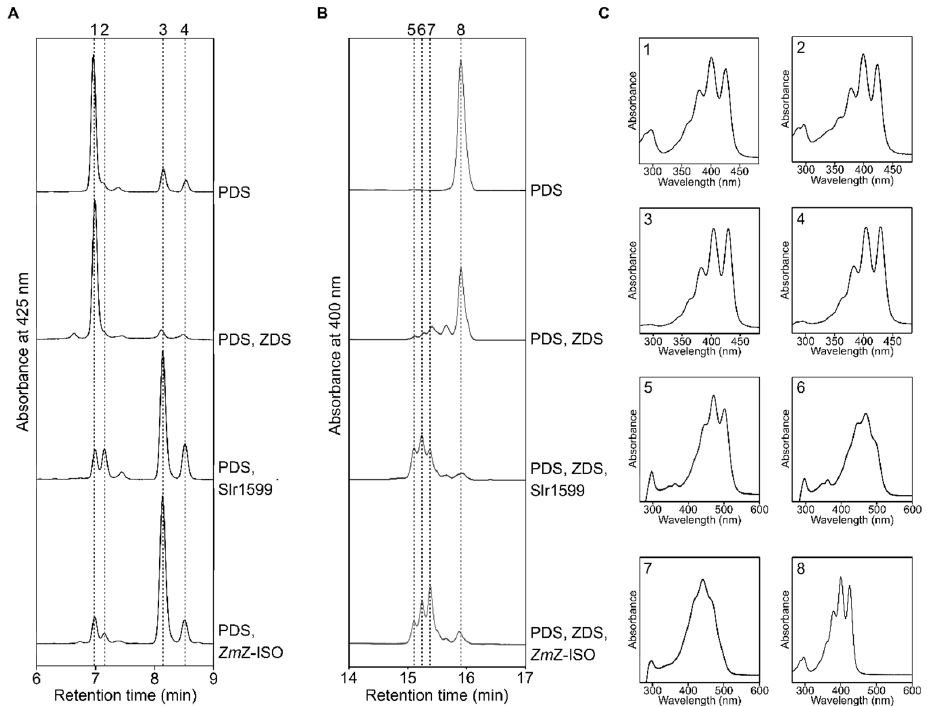
Figure 3. Slr1599 isomerizes 9,15,9 (cid:48) -tri- cis - ζ -carotene when produced in E. coli . ( A ) RP-HPLC anal- ysis of carotenoids extracted from dark-grown E. coli cells containing pAC-ZETAipi and either empty pCDFDuet Tm -1 (labeled PDS), pCDFDuet Tm -1 containing Synechocystis crtQ (PDS, ZDS), pCDFDuet Tm -1 containing Synechocystis slr1599 (PDS, Slr1599), or pCDFDuet Tm -1 containing the maize Z-ISO gene (PDS, Zm Z-ISO). Eluted pigments were detected by monitoring absorbance at 425 nm. ( B ) RP-HPLC profile of carotenoids extracted from dark-grown E. coli cells harboring empty pCDFDuet Tm -1 (PDS), pCDFDuet Tm -1 containing Synechocystis crtQ (PDS, ZDS), pAC-ZETAipi and pCDFDuet Tm -1 containing both crtQ and slr1599 (PDS, ZDS, Slr1599) or pAC-ZETAipi and pCDFDuet Tm -1 containing both crtQ and the maize Z-ISO gene (PDS, ZDS, Zm Z-ISO). Eluted pig- ments were detected by monitoring absorbance at 400 nm. ( C ) Absorbance spectra of the numbered carotenoid species in panels (A) and (B). Peaks 1 and 8 = 9,15,9 (cid:48) -tri- cis - ζ -carotene; peak 2 = alternative central cis -isomer of ζ -carotene [44]; peak 3 = 9,9 (cid:48) -di- cis - ζ -carotene; peak 4 = all- trans ζ -carotene [44]; peaks 5–7 = cis -lycopene isomers